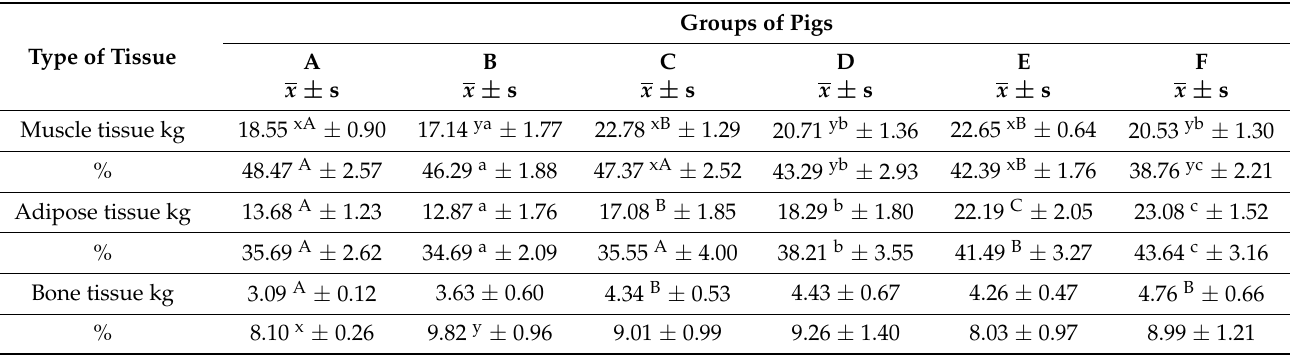
Table 5. Shares of tissue in the